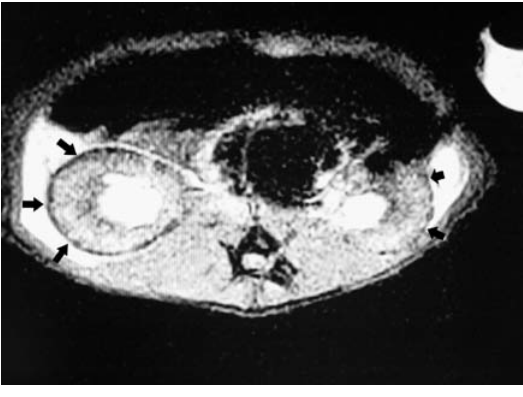
Figure 10 On the 4 th day after labelled mesenchymal stem cell (MSC) transplantation, the signal intensity decrease (arrows) is still visible on the transverse T2*-weighted MR image.